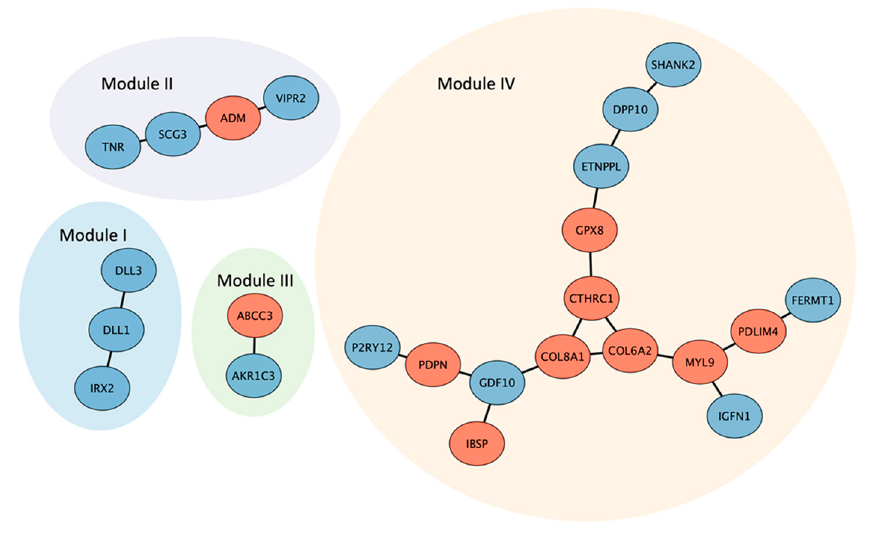
Figure 5. Four linkage modules (I, II, III and IV) of predicted protein–protein interaction networks by STRING. The nodes in red and blue represent the proteins encoded by the over- and underexpressed GBM signature genes, respectively.